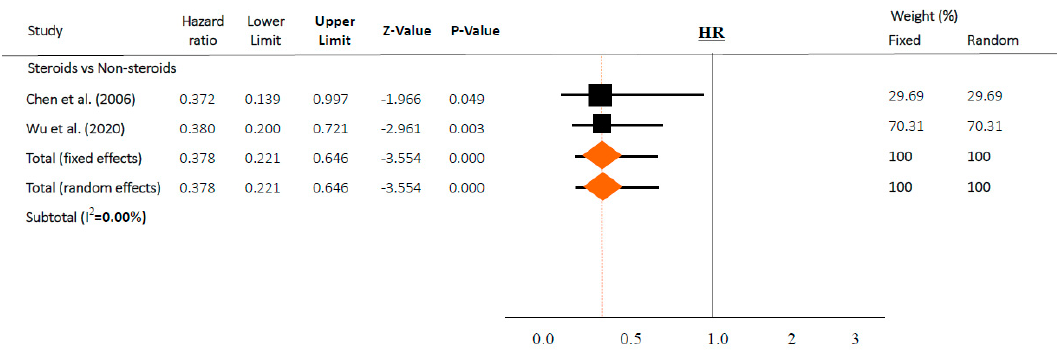
Figure 3. Association between steroids and mortality of studies adjusted for comorbidities or time-dependent conducted studies. Studies are presented as country study (study [year]). Meta-analysis was performed using hazard ratio (HR).